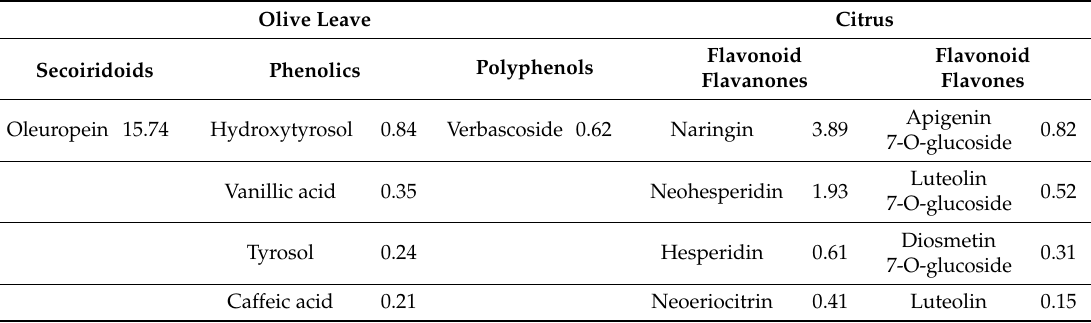
Table 1. Absolute content (% w / w , according to the corresponding standards) of the main bioactive compounds classified by main chemical family and plant origin. Other bioactives are trace, less than